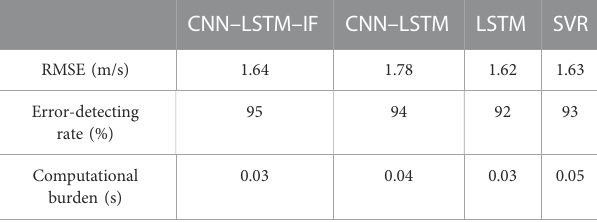
TABLE 1 Performance of different methods for RMSE, error-detecting rate, and the computational